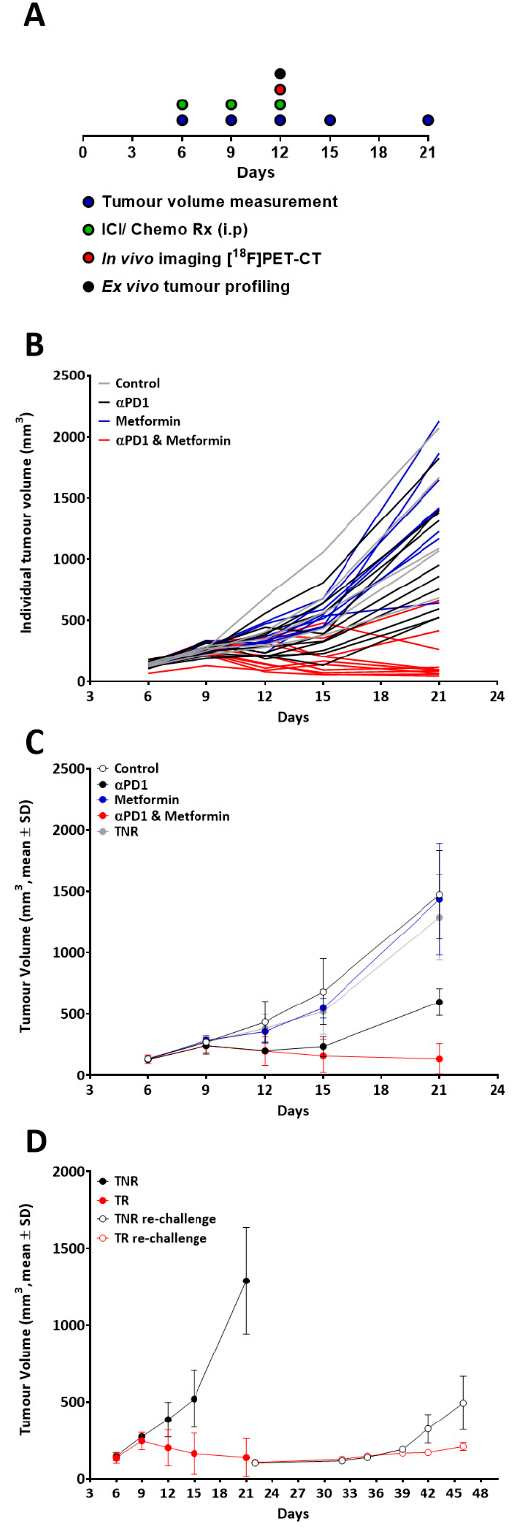
Figure 1. ( A ) Schematic showing the treatment, tumour volume assessment and imaging regimen. ( B ) Individual tumour volumes for each animals highlighting the variability in response. ( C ) Tumour volumes in each treatment cohort after therapy response stratification. ( D ) Average tumour volume after tumour re-challenge. Data are represented as mean ± S.D. (TR, responding tumours; TNR, non-responding tumours).